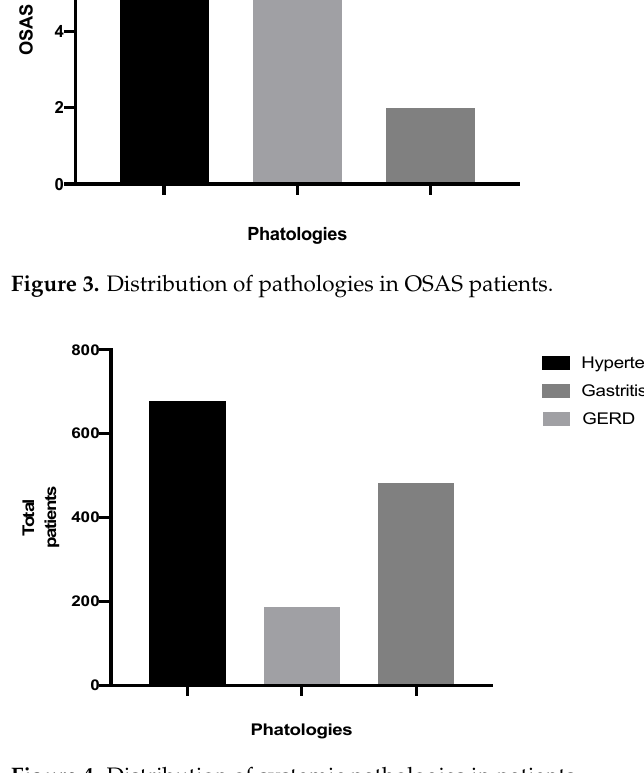
Figure 4. Distribution of systemic pathologies in patients.